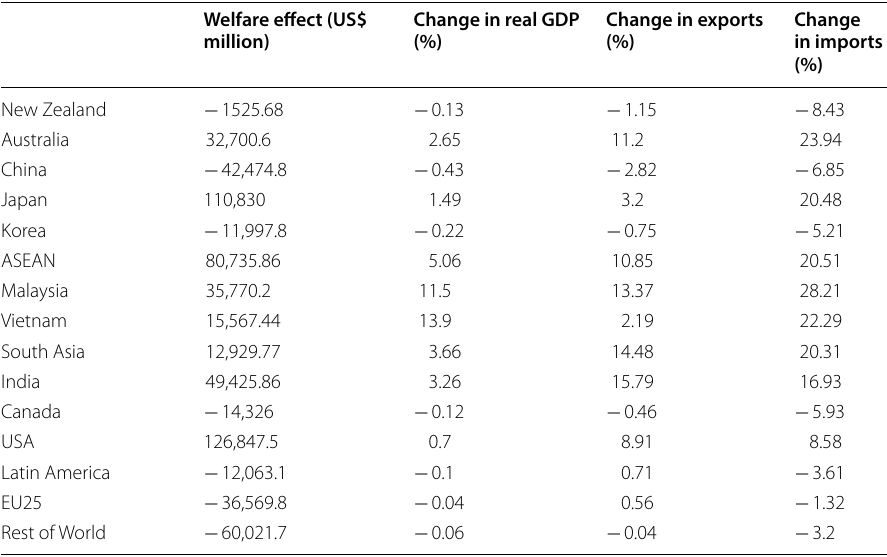
Table 7 Macroeconomic impact under Indo-Pacific 2: tariff eliminations and 25% increase in trade facilitation. Source: Authors’ simulation from GTAP version 9